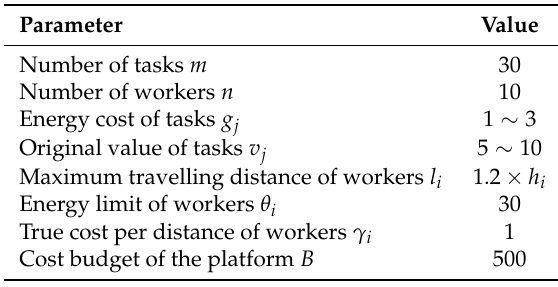
Table 2. Simulation parameters.